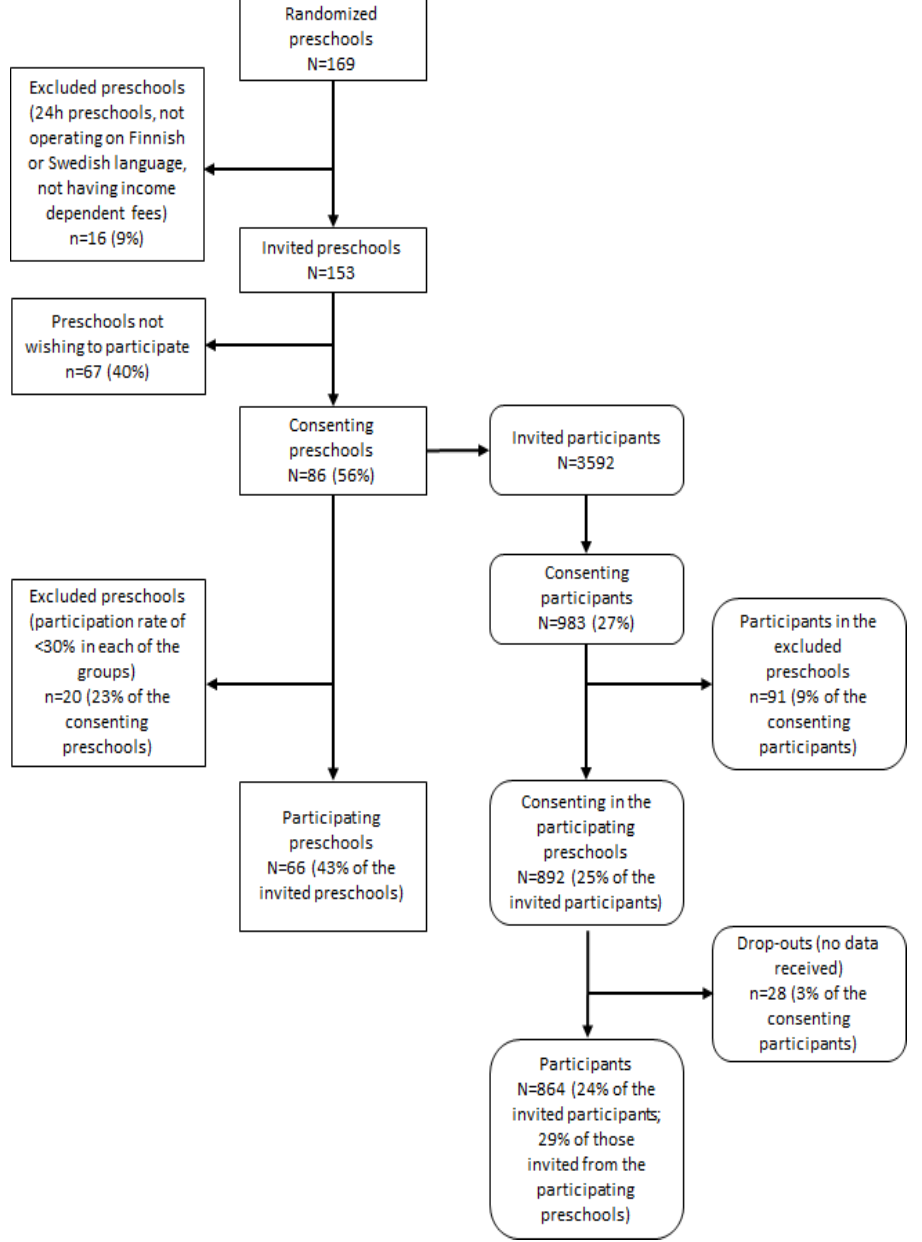
Figure 1. Participation and exclusion of preschools and families in the DAGIS survey.